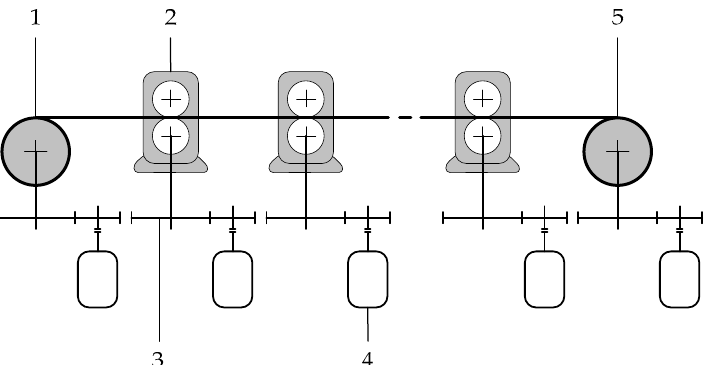
Figure 1. Process Flowsheet & Kinematic Diagram of The Continuous n -Stand Rolling Mill Drives: 1: unwinder; 2: rolling stand; 3: reducer; 4: motor; 5: winder.